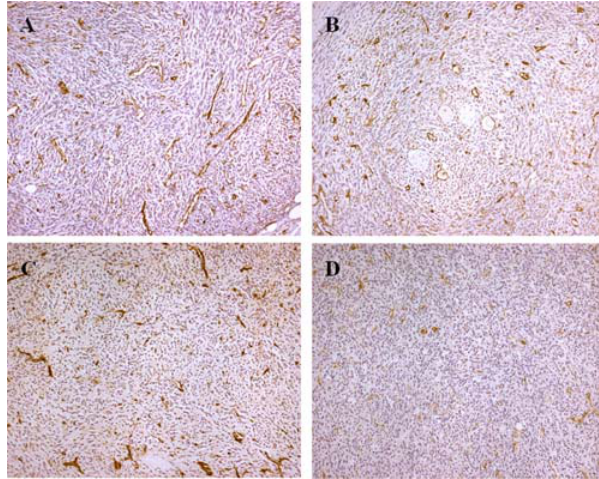
Figure 5. Immunohistochemical analysis of the tumour vasculature evolution by means of CD 31 staining in LPB tumors after treatment. A: control; B, C and D: respectively 2, 6 and 24 h after IRE.